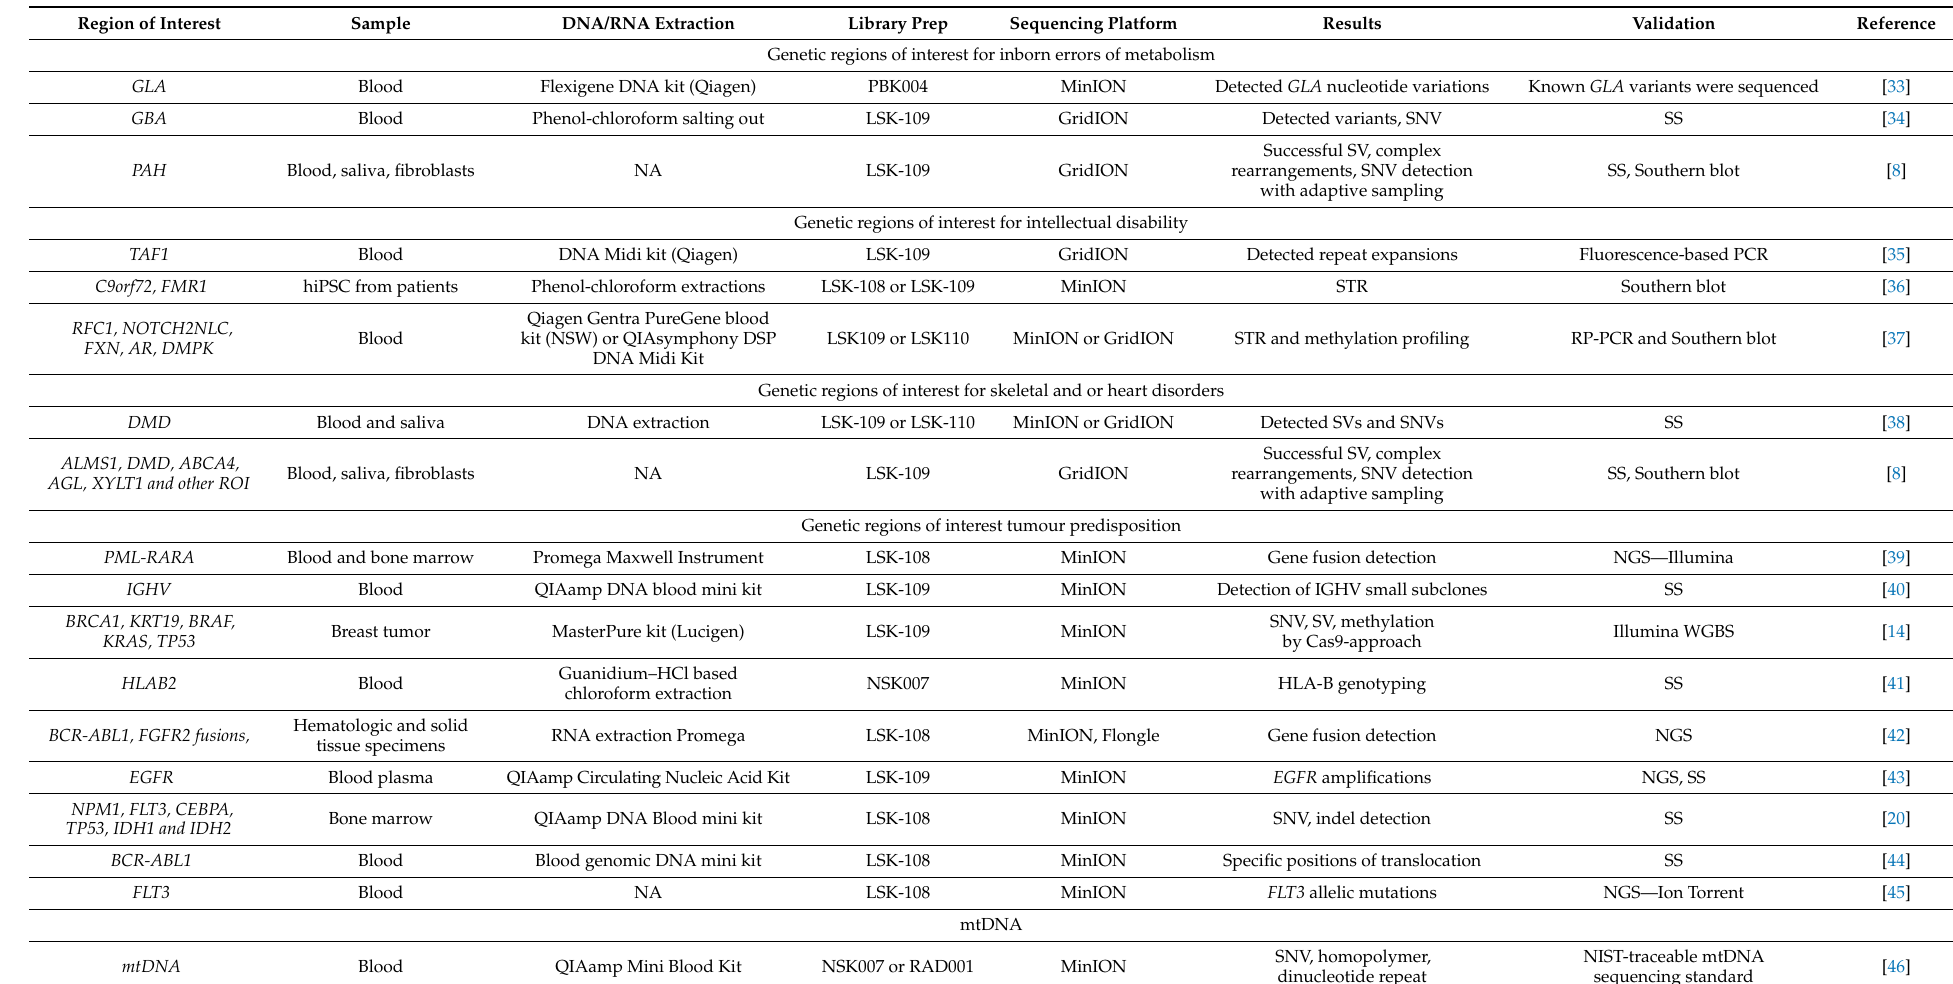
Table 1. Clinically actionable gene alterations successfully detected by ONT from processed human